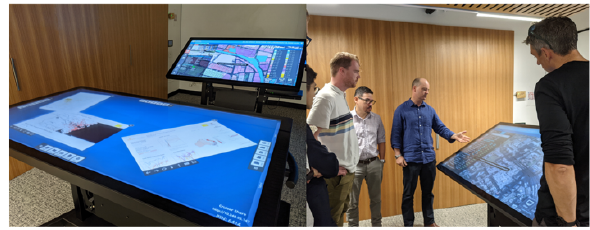
Figure 1 : Collaborative interactive tables in planning theatre of City Analytics Lab, UNSW,